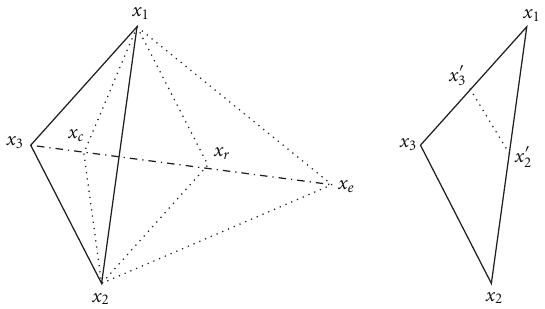
Figure 2: Four operations in downhill simplex method. ( x r : reflection, x e : expansion, x c : contraction, x (cid:5) 2 , x (cid:5) 3 :